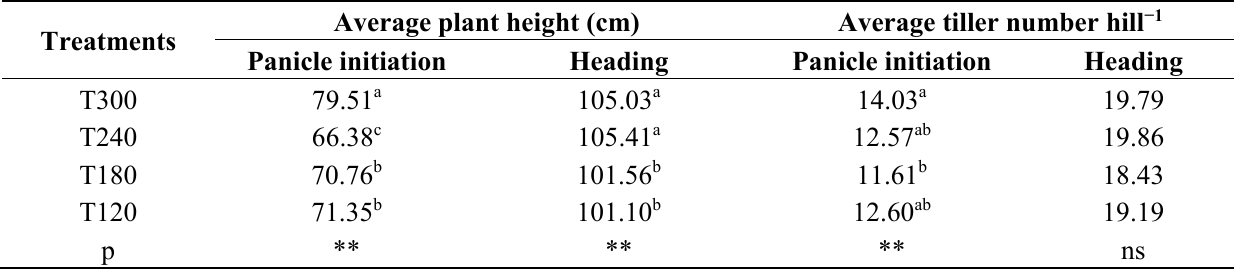
Table 1. Different water amount effects on plant height and tiller